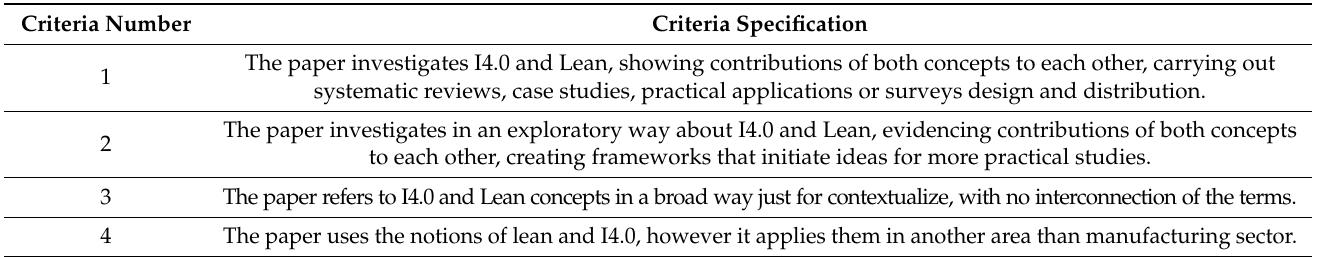
Table 2. Exclusion and inclusion criteria specification.